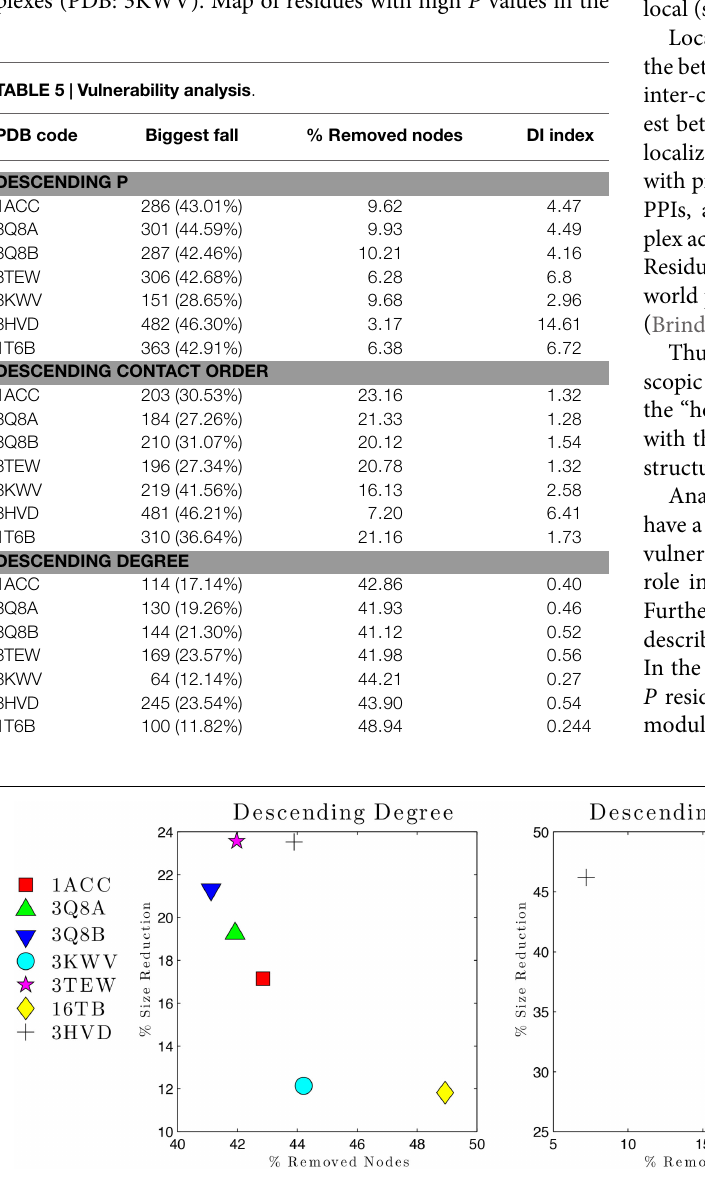
FIGURE 6 | Network vulnerability upon nodes removal strategies